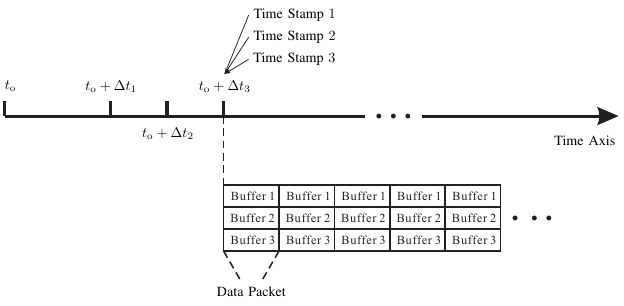
Figure 4. The time axis for configuring the universal software-defined radio peripherals (USRPs) parameters and transmitting the data packet for the time synchronization method in the proposed performance-evaluation